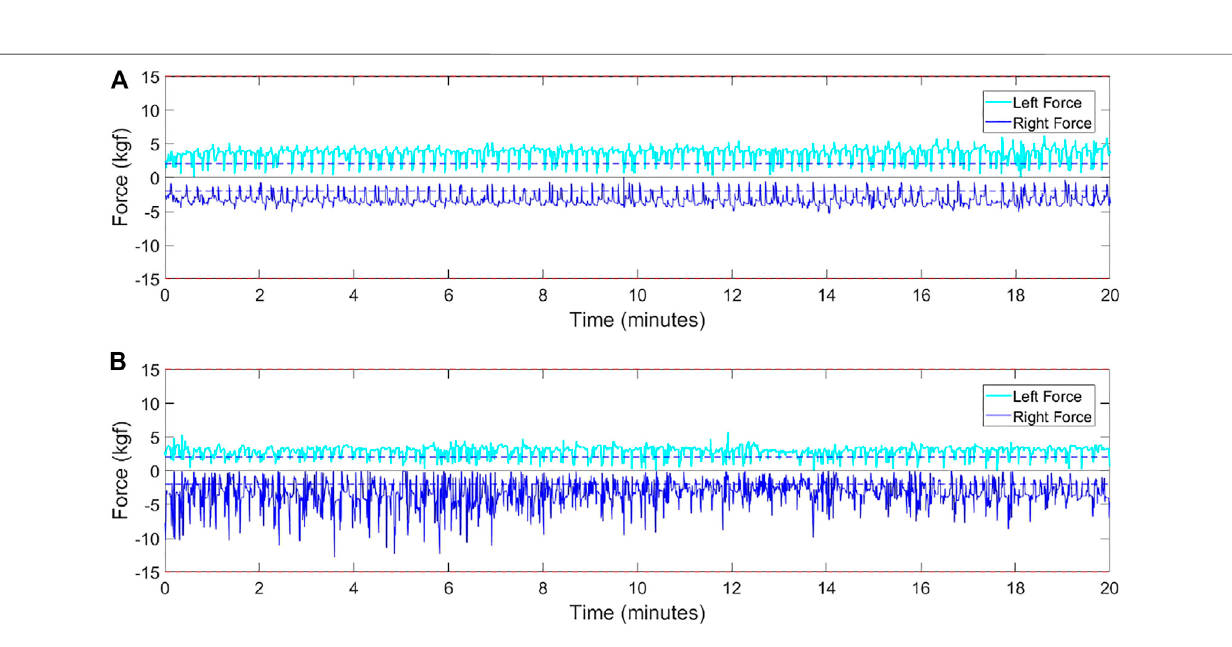
Frontiers in Robotics and AI |